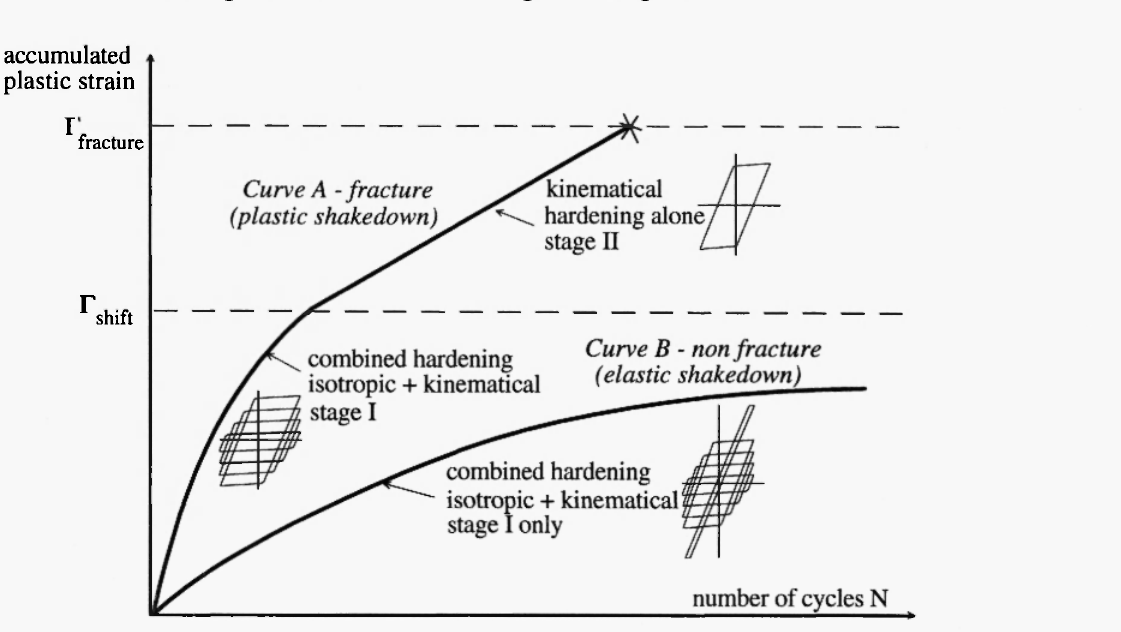
Figure 4. Accumulated plastic strain in function of the number of loading cycles Accordingly the methodology of the mesoscopic approach to the problem of the fatigue limit can be stated as follows. Let us accept that the crystal has an elastoplastic behaviour with a combined isotropic and kinematical hardening. Let us assume furthermore that the capabilities of the crystal to harden in an isotropic manner are unlimited; even after an infinite number of load cycles the crystal keeps an isotropic hardening component. Therefore, under a cyclic load it will tend to an elastic shake- down state. As will be shown later, it is possible to calculate the asymptotic value of the accumulated plastic mesostrain, denoted as Γ^, which corresponds to the elastic shake-down state. If Γ«, is higher than the critical amount r that marks the shift from sh combined isotropic and kinematical hardening to kinematical hardening alone, then